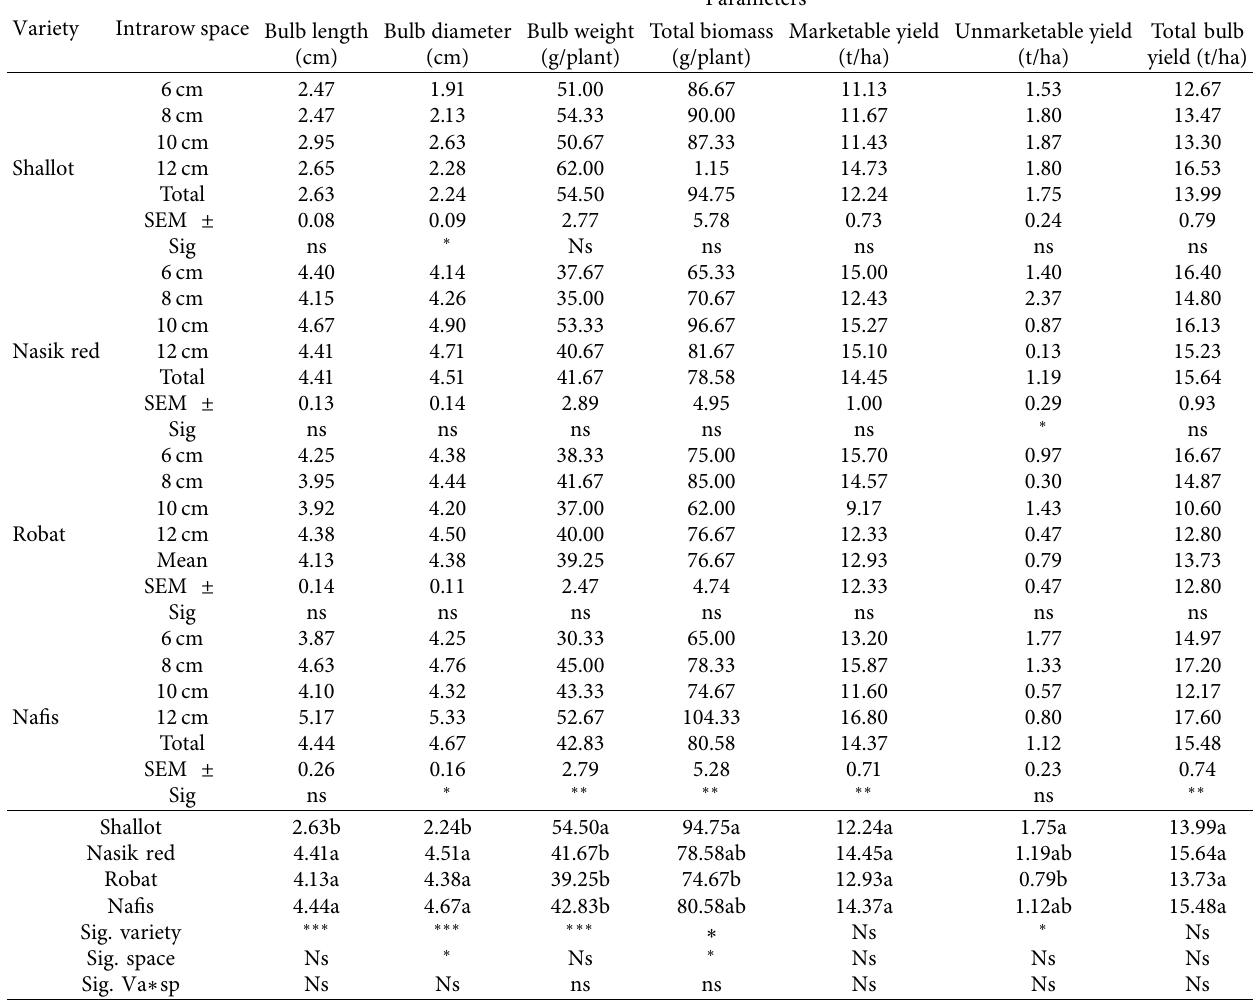
Table 5: Infuence of varieties, intrarow spaces, and their interaction efects in yield and yield components.